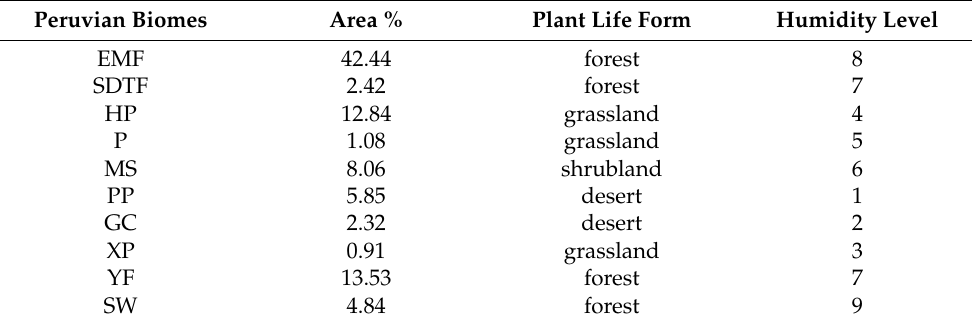
Table 1. Distribution of biomes in Peru, percentage of coverage area, type of predominant ecological structure, and relative humidity